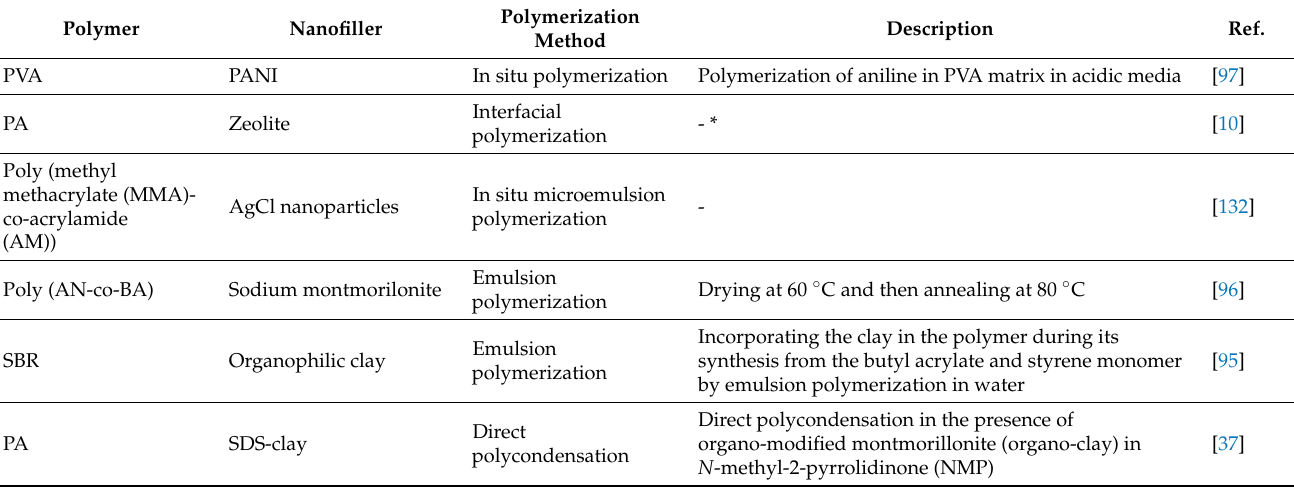
Table 3. PV nanocomposite membranes prepared using polymerization method reported in the